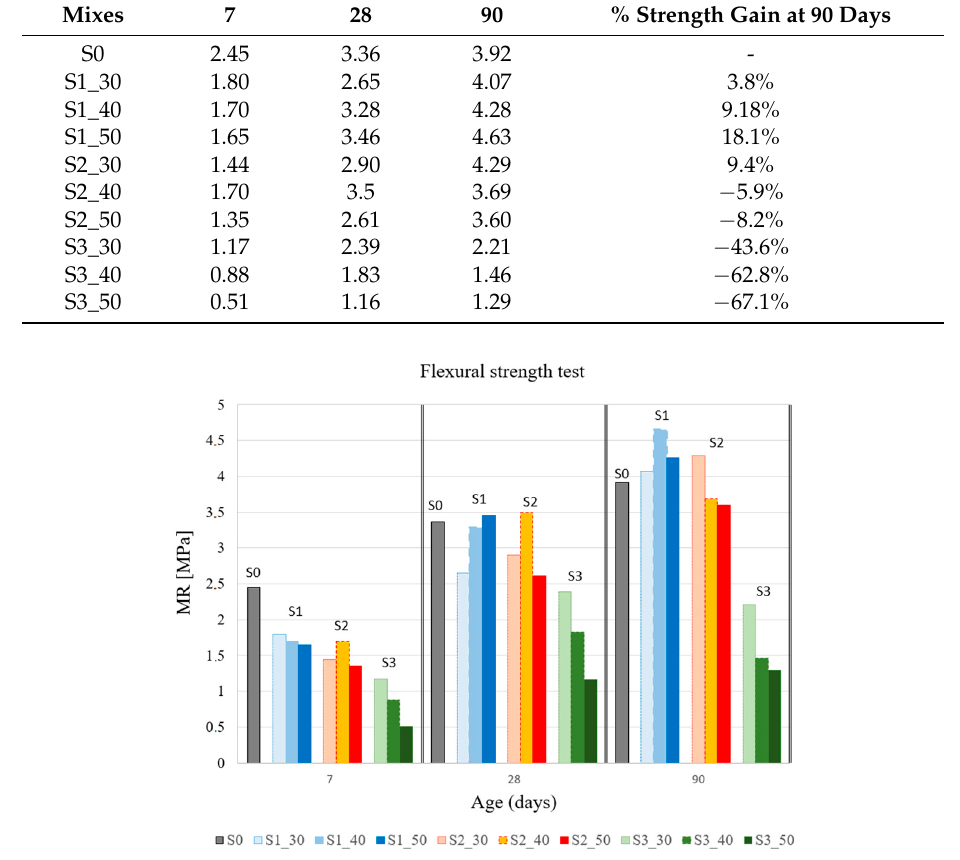
Table 3. Flexural strength results.